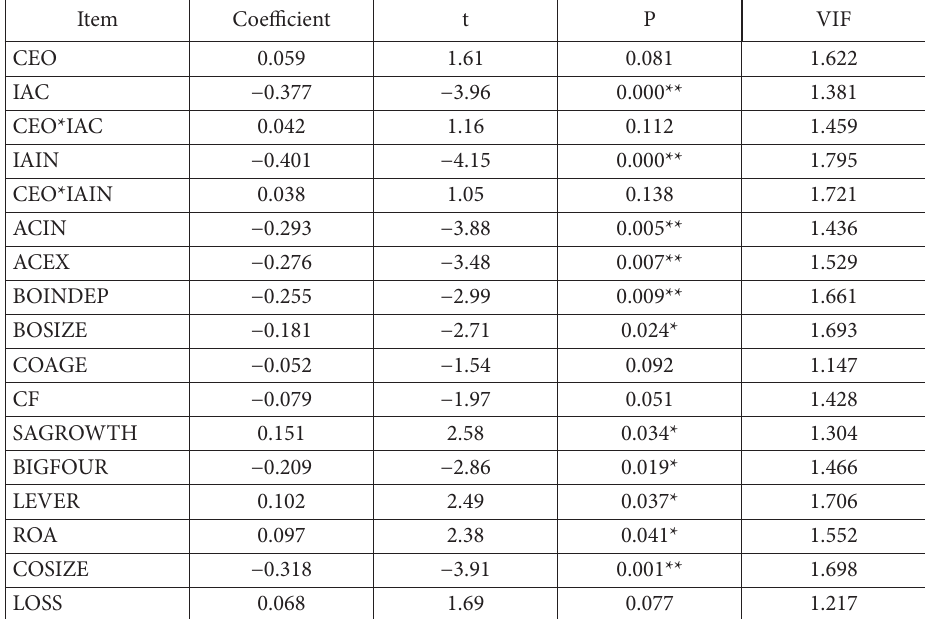
Table 5. Regression results of model 6 −